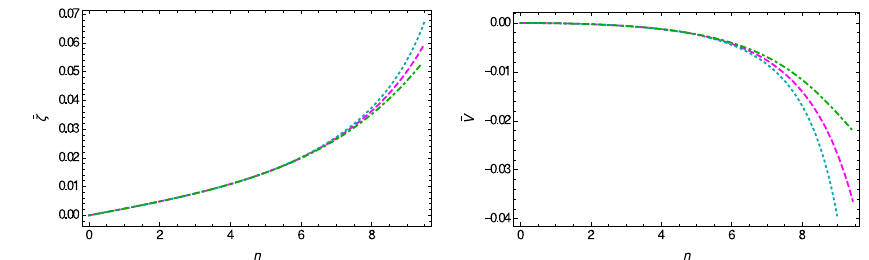
and ¯ b = 0 . 11 (dot-dashed curve), respectively. The central density of the photon star is ρ mc = 7 . 12 × 10 14 g / cm 3 , while ¯ ζ 0 = 0 and ¯ ζ (cid:13) = 7 × 10 − 3 , respectively 0